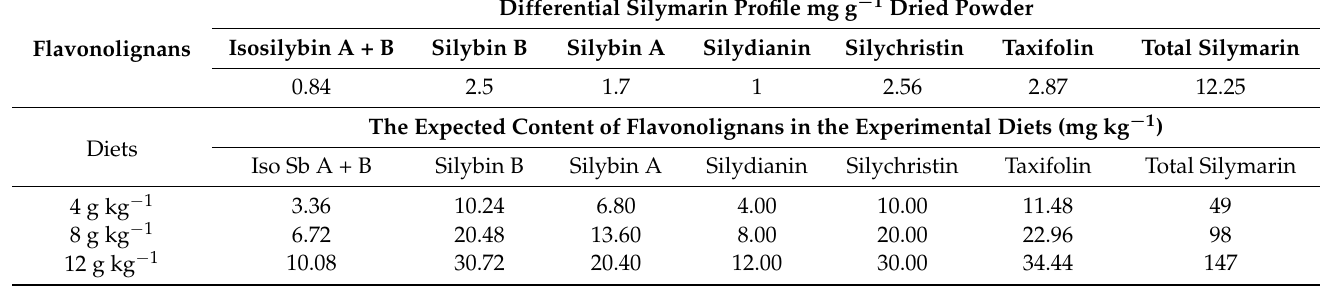
Table 2. Flavonolignans profiling in S. marianum dry seeds using high-performance liquid chromatog- raphy (HPLC) analysis and their expected content in the experimental diets.